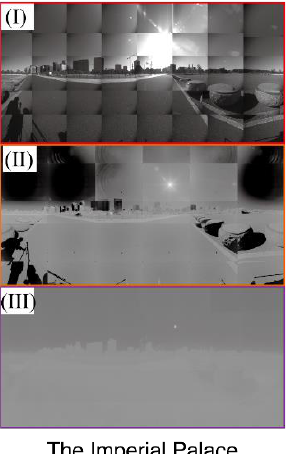
Figure 11. Measured image in winter experiment at the Imperial Palace with ( I ) visible, ( II ) near- infrared, and ( III ) far-infrared light camera.